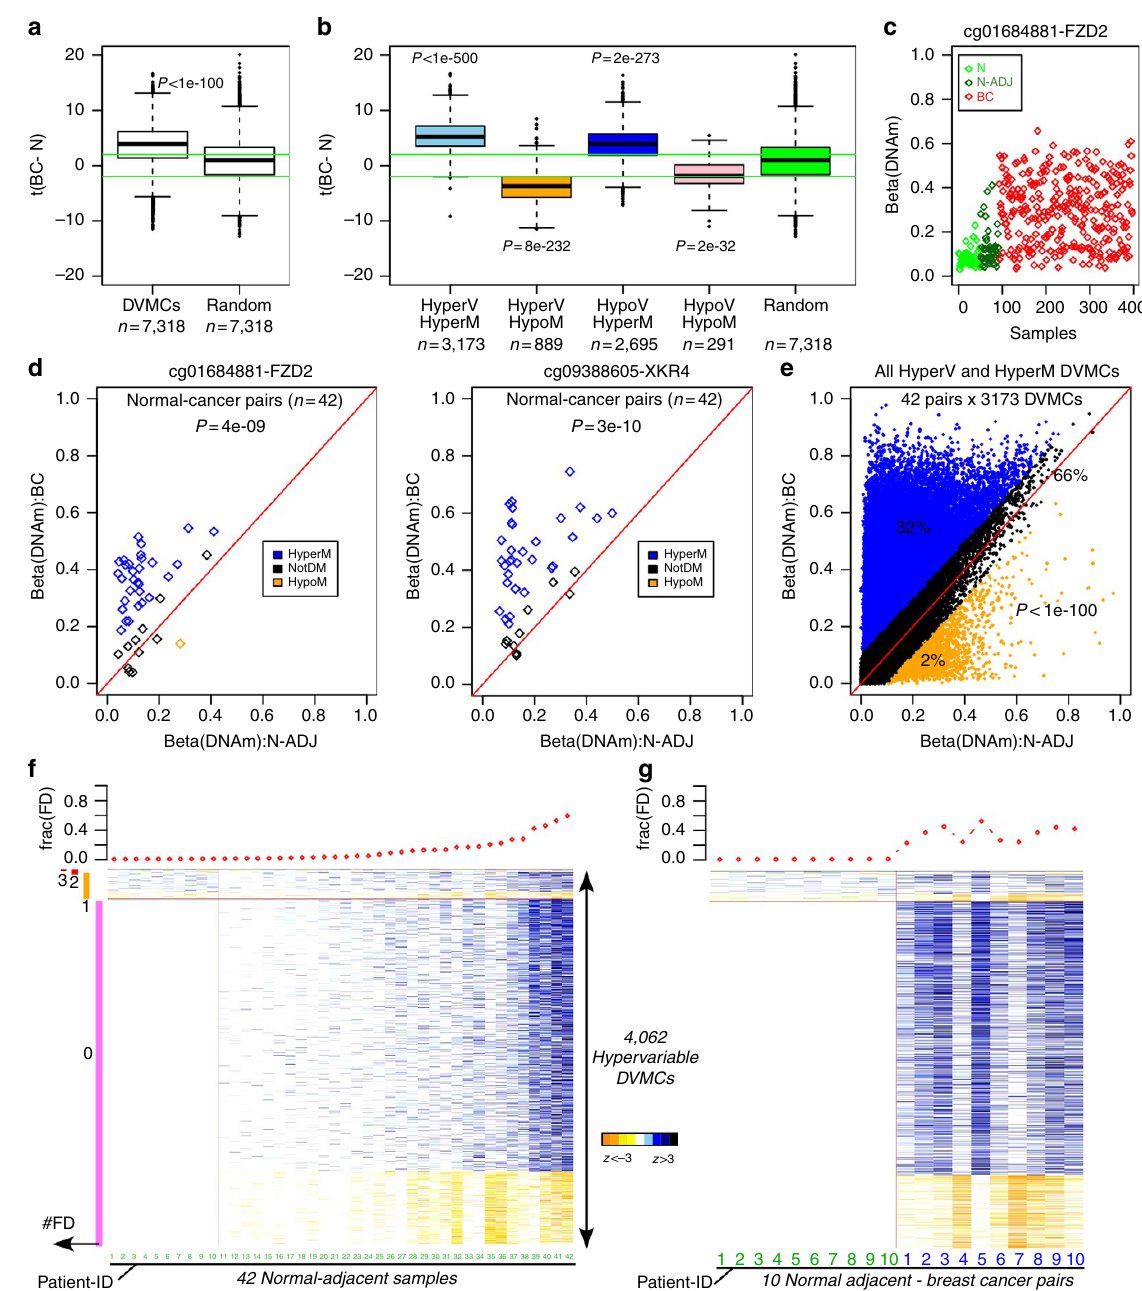
Figure 3 | Progression of field defects in breast cancer. ( a ) Box plot of t -statistics of differential DNA methylation between the 305 breast cancer (BC) patients and the 50 normals (N) from healthy women ( y axis: t(BC-N)) for the 7,318 DVMCs, compared with a random selection of CpGs. Positive t -statistics indicate larger DNAm values in BC compared with N. Wilcoxon-rank sum test P -value is given. Horizontal green lines indicate the lines of P ¼ 0.05. ( b ) As a , but with the DVMCs broken up into four categories, according to whether CpG is hypervariable or hypovariable and whether the difference in mean DNA methylation is increased (hypermethylated) or decreased (hypomethylated) in the 42 normal adjacent samples compared with the 50 true normals. ( c ) Example of a DNAm profile of a hypervariable and hypermethylated DVMC, showing the progressive change in DNA methylation. ( d ) Scatter plots of DNA methylation for two DVMCs, restricting to the 42 matched normal–tumour pairs, with x axis labelling the beta-value in the normal adjacent sample, and y axis labelling the corresponding beta-value in the matched breast tumour. Paired Wilcoxon test P -values are given. Blue and orange points represent breast cancer patients for which the change in mean DNA methylation between normal-adjacent and cancer was larger than 0.1 in absolute terms, with blue indicating hypermethylation and orange hypomethylation. ( e ) As d , but now for all 3,173 hypervariable and hypermethylated DVMCs superimposed on same plot. We provide the proportion of data points that exhibit hypermethylation (blue), no significant changes (black), and hypomethylation (orange). ( f ) Top plot shows the fraction of hypervariable DVMCs (aka field defects, frac(FD)) significantly altered in each normal- adjacent sample, with samples ordered in increasing order. Left colour bars mark the DVMCs with the number of significant DNAm alterations that they exhibit across the ten samples exhibiting the lowest fractions of alterations. Heat map depicts the z -scores of differential DNAm change for each DVMC and normal-adjacent sample relative to the normal-state, with samples ordered according to the overall fraction of alteration. ( g ) As f , but now restricting to the ten normal-adjacent breast cancer pairs corresponding to the ten patients with the lowest fractions of DNAm alterations in normal-adjacent tissue. NATURE COMMUNICATIONS|7:10478|DOI: